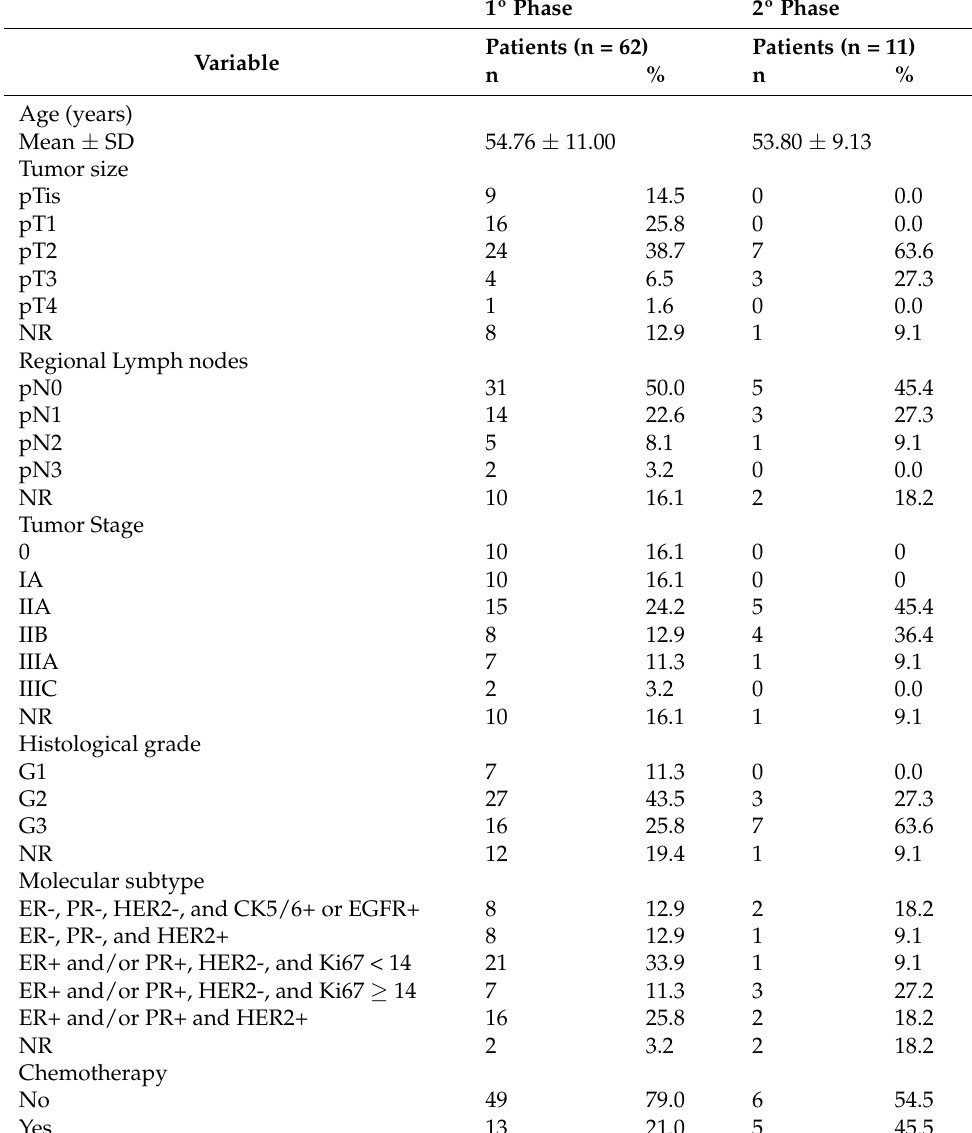
IIIB. Table S2 details the tumor staging of the studied groups (BC with chemotherapy and BC without chemotherapy), and is available in the Supplementary Material. Out of the 62 patients, 7 (27.4%) had histological grade 1 (G1) tumors, 27 (43.5%) presented histological grade 2 (G2), and 16 (25.8%) presented histological grade 3 (G3). Regarding the molecular subtype, 8 patients (12.9%) had estrogen receptor (ER)-negative, progesterone receptor (PR)-negative, human epidermal growth factor receptor 2 (HER2)-negative, and CK5/6-positive or epidermal growth factor receptor (EGFR)-positive; 8 patients had ER-, PR-, and HER2+; 21 patients (33.9%) had ER+ and/or PR+, HER2-, and Ki67 < 14%; 7 patients (11.3%) had ER+ and/or PR+, HER2-, and Ki67 ≥ 14; and 16 (25.8%) had ER+ and/or PR+ and HER2+. Most of the patients—49 (79%)—had not yet started CT (BC without CT); 13 BC patients had concluded CT (BC with CT). Table 1. Clinical, hormonal, and therapeutic characteristics of breast cancer patients. 1º